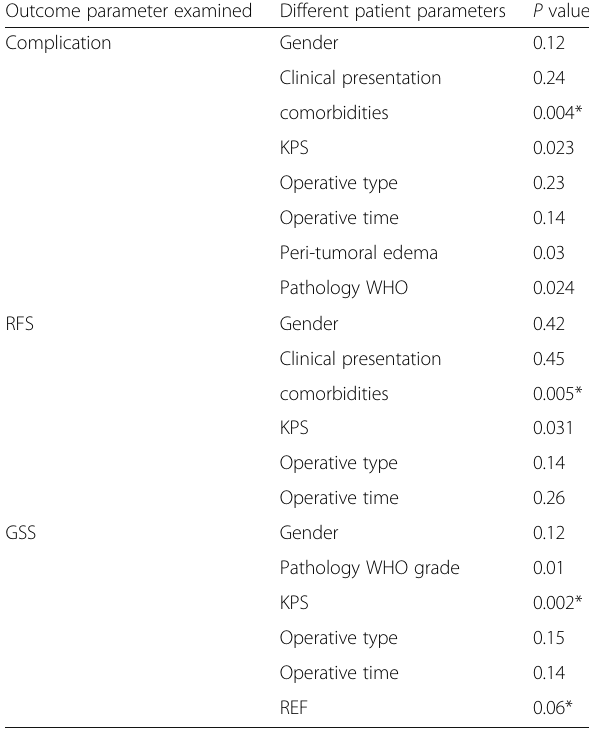
Table 4 Univariant analysis of the complication, RFS, and GSS score versus different parameters Outcome parameter